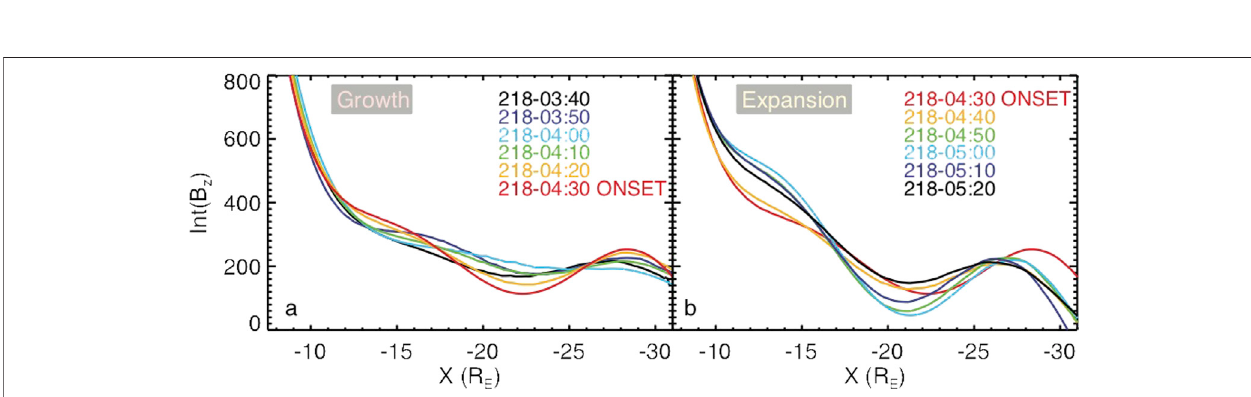
FIGURE 9 | Analogs of Figs. 5n and 5o, now showing the line integral Int ( B z ) (cid:1) (cid:23) B z ds over the arcs similar to dashed blue arcs in Figure 7A from dusk to dawn magnetopause boundaries (and expressed in units nT R E ) as a function of the arc ’ s most tailward value of x . The function Int ( B z ) better re fl ects the redistribution of the magnetic fl ux over the tail taking its width in the dawn-dusk direction into